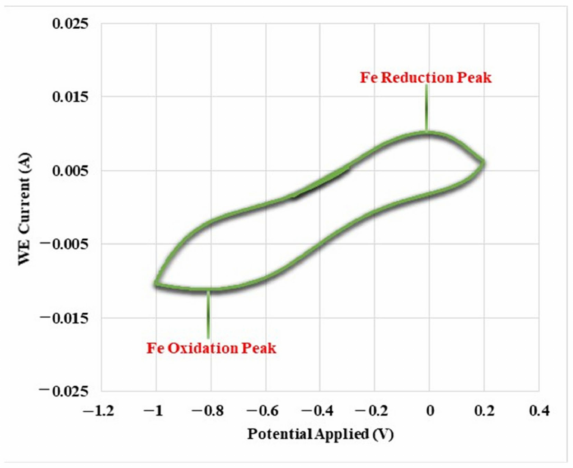
Figure 3. Anodes Cyclic Voltammetry details with Fe redox